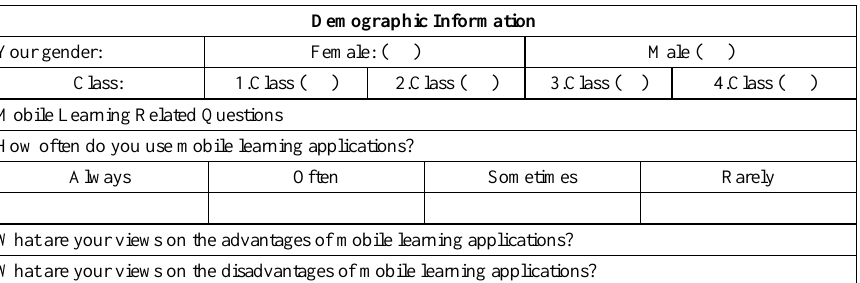
Table 2. Semi-structured interview